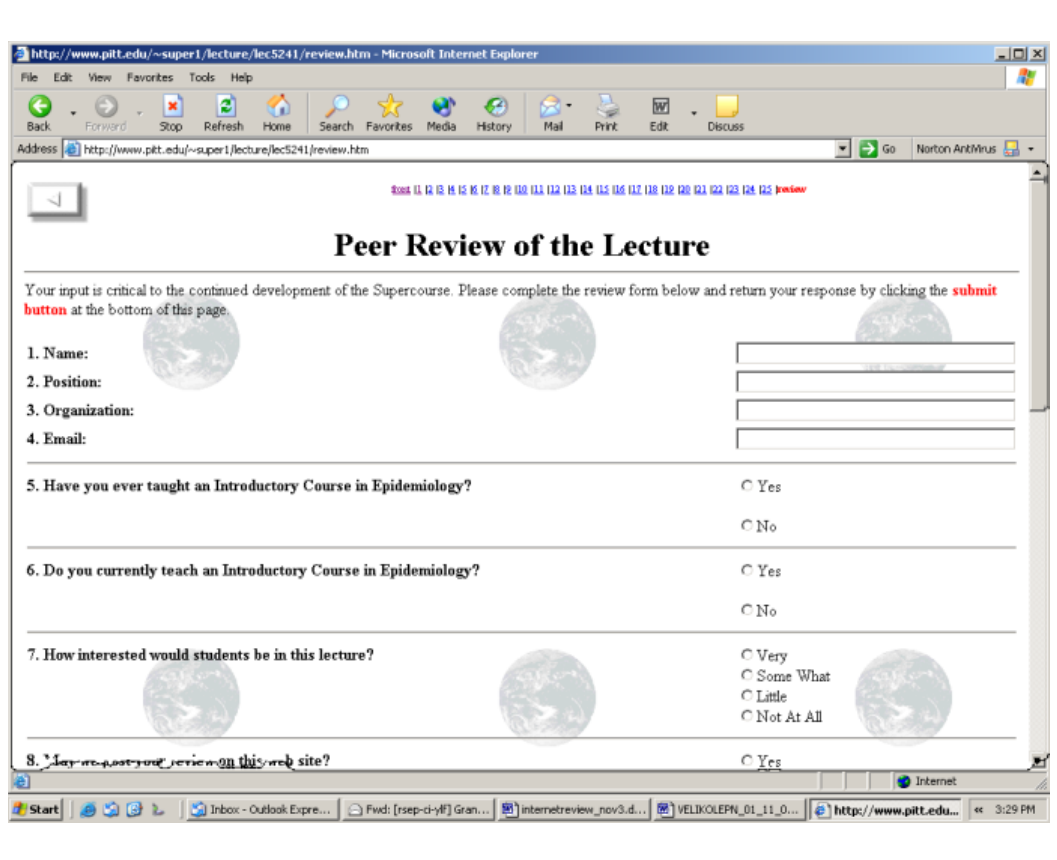
Figure 1: Lecture Review form, Supercourse